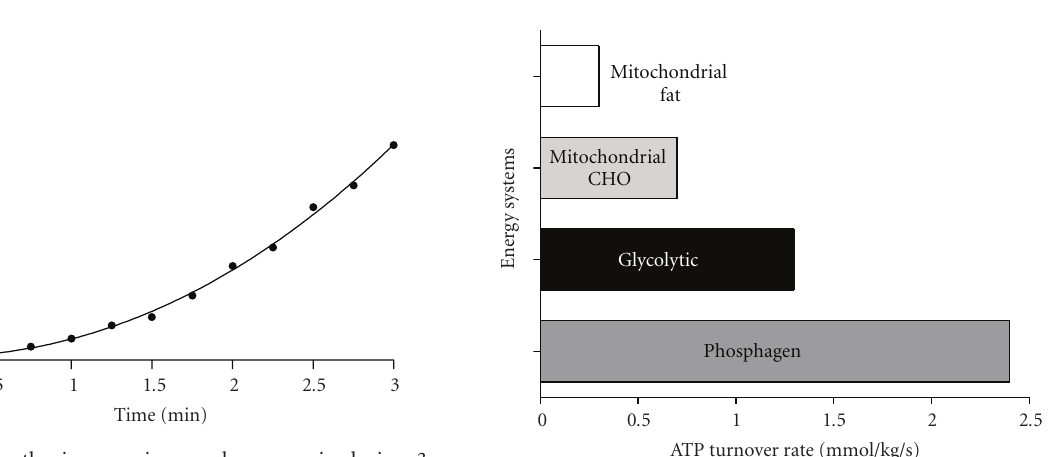
Figure 4: Data for the increase in muscle ammonia during 3 minutes of intense exercise to fatigue. Data are modelled from known changes in muscle IMP and amino acid oxidation. Adapted from Spriet et al. [2], (1987a, 1987b), Medbo et al. [18], Kemp et al. [19], and Bendahan et al. (2003).